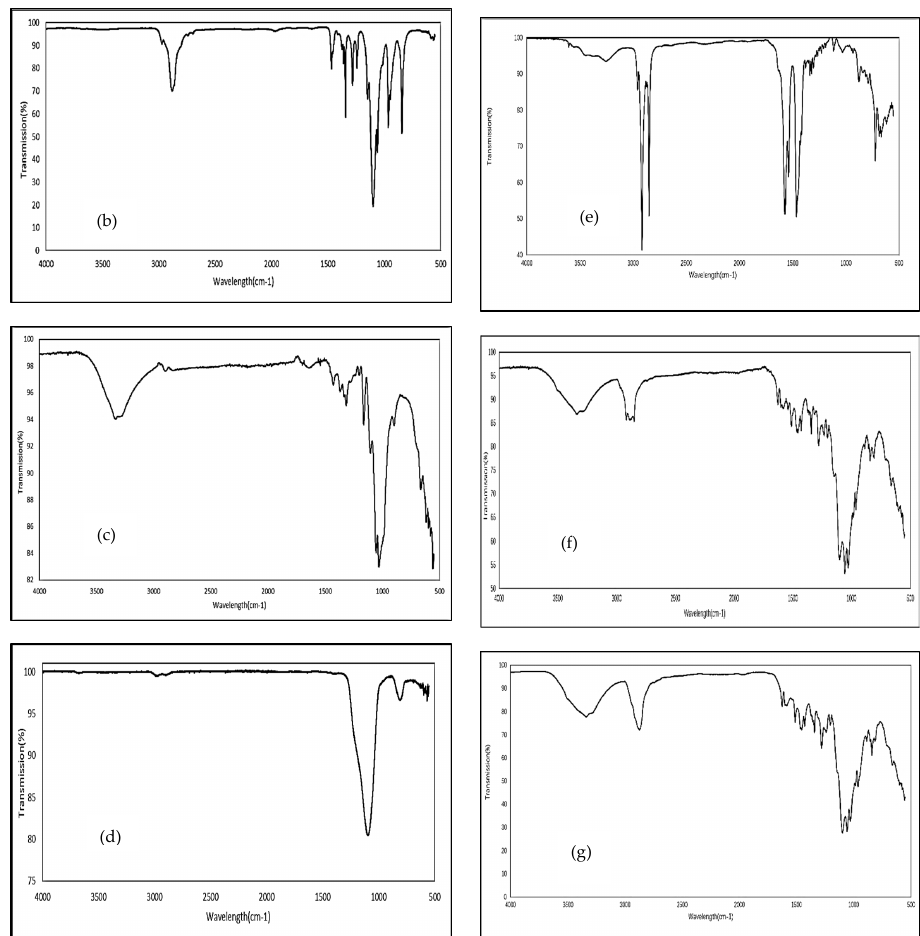
Figure 4. FTIR spectra of the ( a ) PEG400, ( b ) Poloxamer 407, ( c ) MCC, ( d ) Aerosil®, ( e ) magnesium stearate, ( f ) Formulation B, and ( g ) the physical mixture of Formulation B (curcumin: PEG400: Poloxamer 407: MCC: Aerosil®: magnesium stearate 1:0.5:0.9:5.6:0.1:0.1).